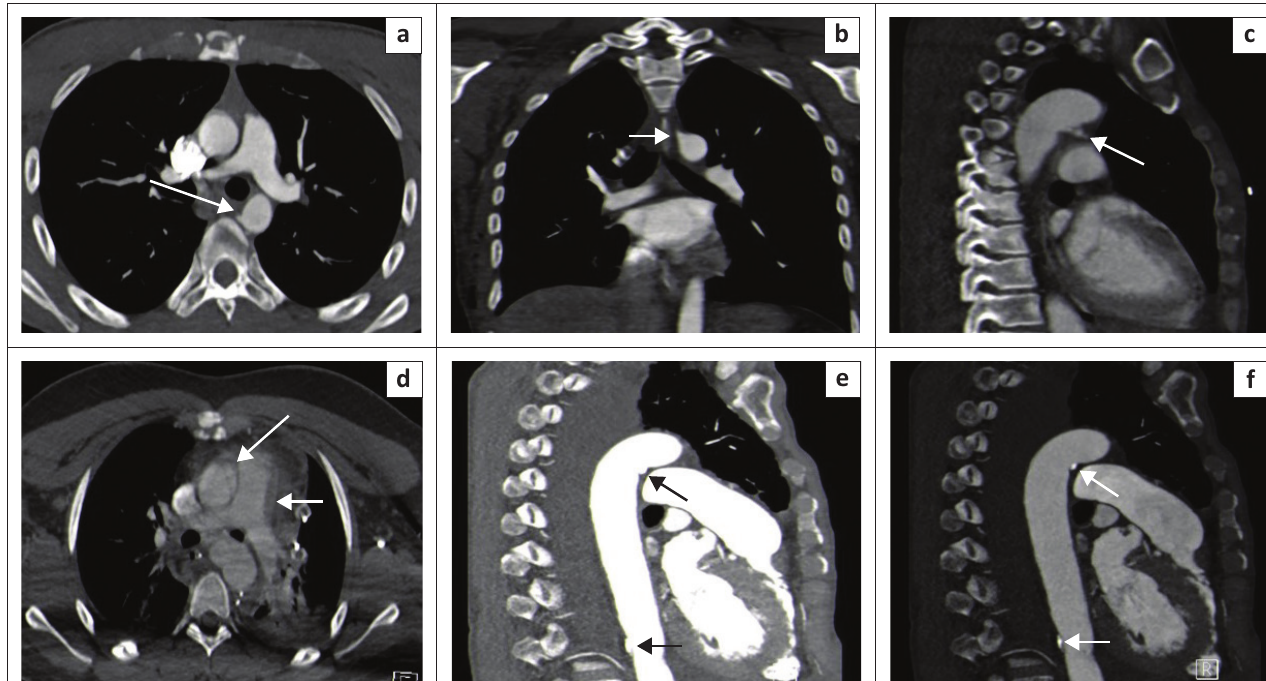
FIG URE 10: Examples of pitfalls in some of our patients. Long arrows in (a) and (b) demonstrate a thoracic aorta vessel branch mistaken for a small pseudoaneurysm. Image (c) arrow shows an aortic diverticulum with overlying minimal wall calcification. Image (d) arrows show motion artefact, not to be mistaken for dissection. Arrows in image (e) show apparent aortic wall abnormalities mistaken for post traumatic injury, but on adequate adjustment of window settings these were wall calcifications